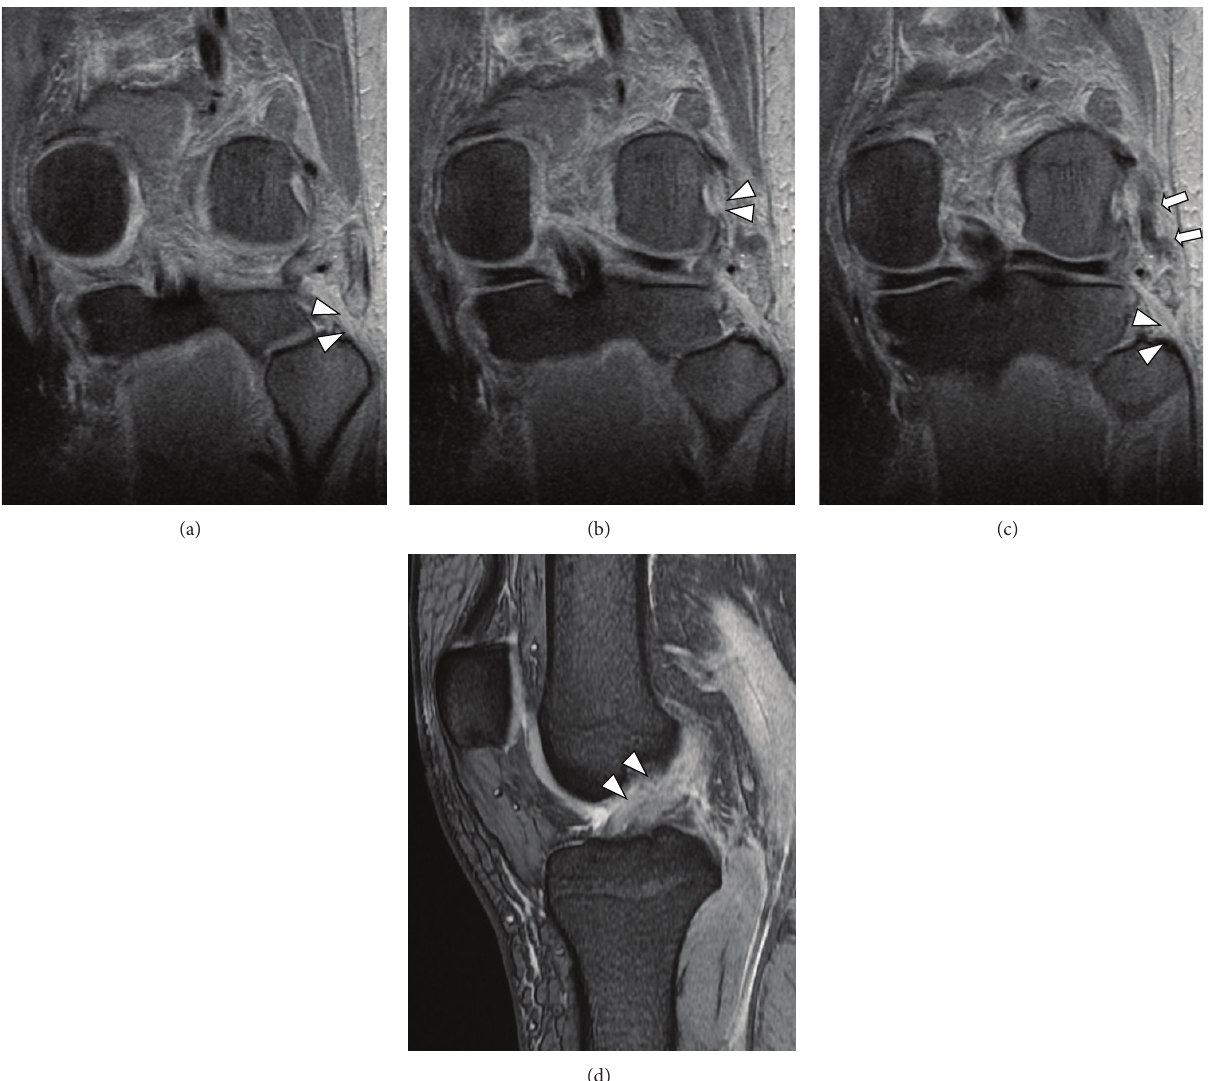
Figure 2: (a) Magnetic resonance imaging (MRI; T2 weighted coronal image) showing the absence of the biceps femoris tendon (arrow head). (b) MRI (T2 weighted coronal image) showing the popliteus muscle tendon rupture at the femoral attachment (arrow head). (c) MRI (T2 weighted coronal image) showing the lateral collateral ligament (LCL) rupture at the fibula head (arrow head) and substance of the LCL (arrow). (d) MRI (T2 weighted sagittal image) showing the anterior cruciate ligament rupture (arrow